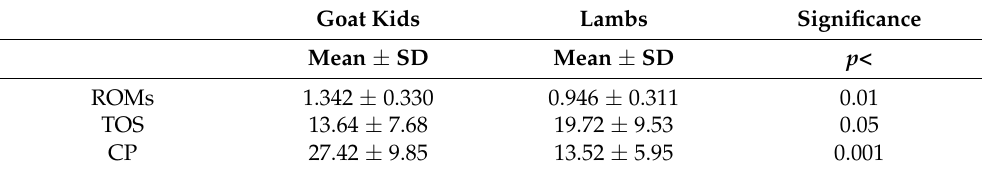
Table 1. Mean ( ± SD) values of the LOOH content evaluated using ROMs and TOS assays, and the ceruloplasmin oxidase activity in blood serum of Comosciata delle Alpi goat kids (n = 16) and Italian Merino-derived lambs (n =